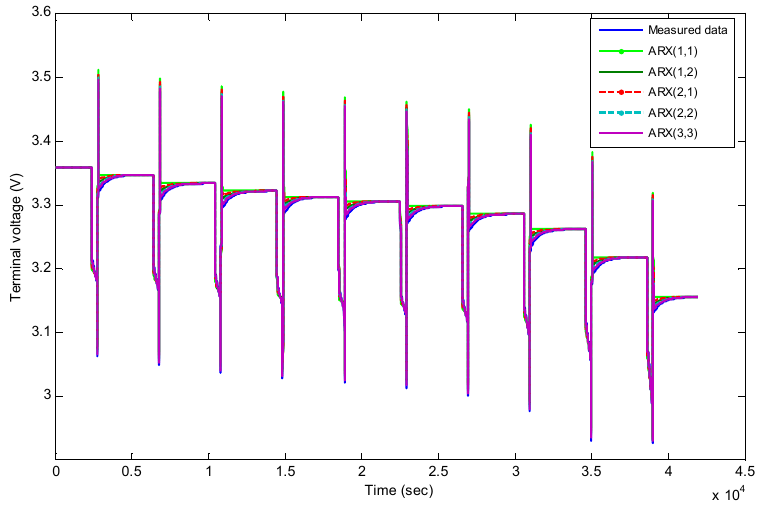
Figure 11. The terminal voltage profiles of the five ARX models simulation and experiment.